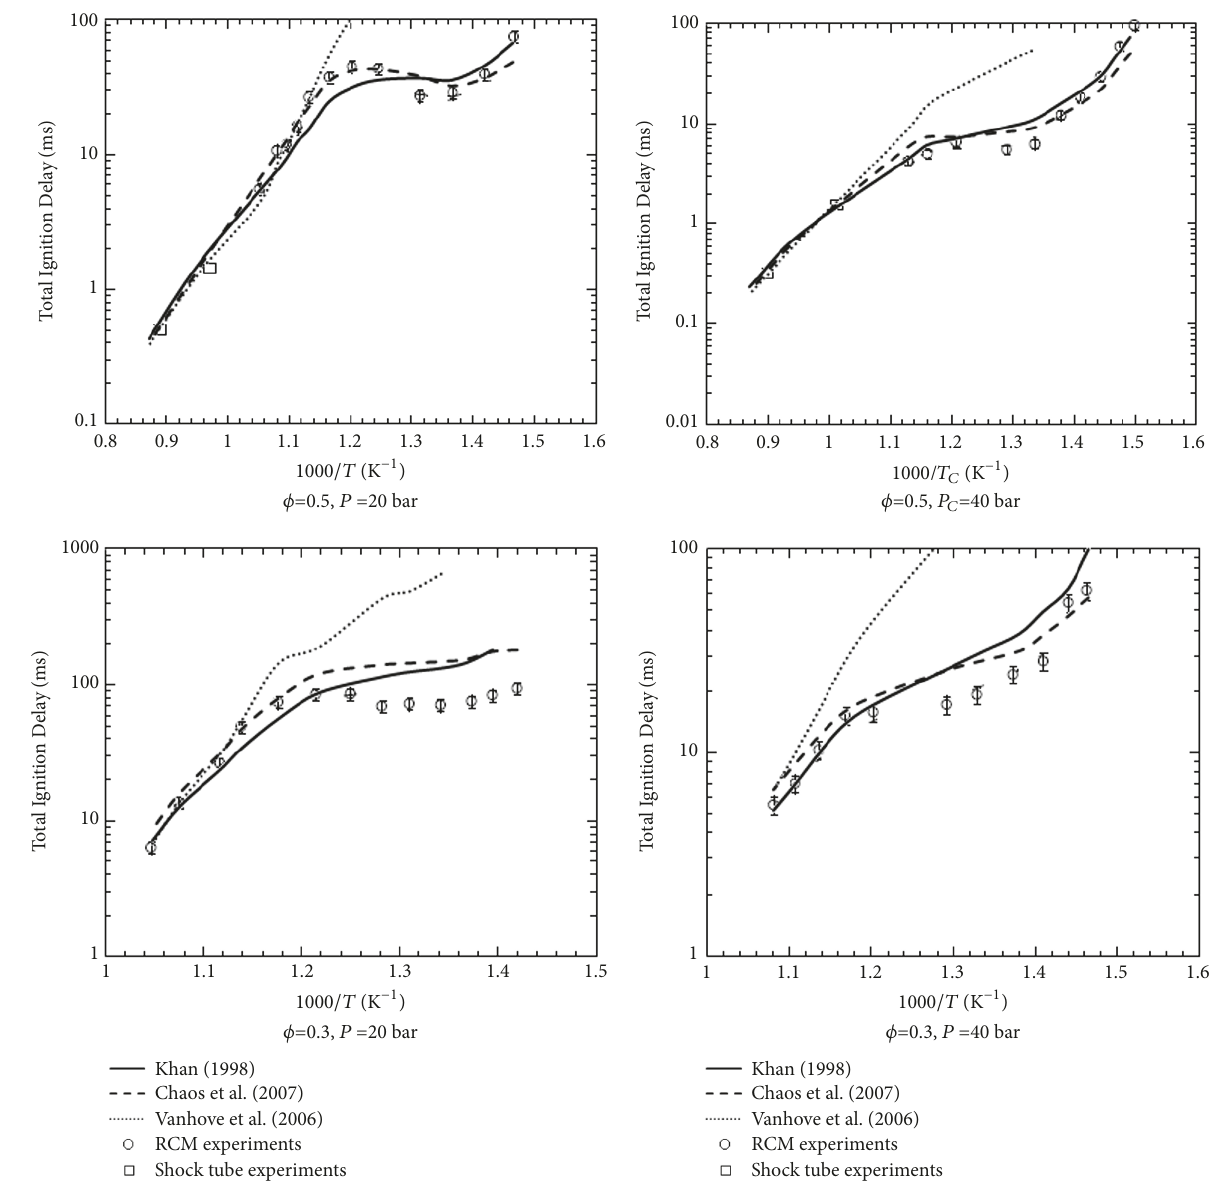
Figure 13: Comparison of RD387 experimental and simulated surrogate total ignition delay times. Experimental data is from Kukkadapu et al. [23] and Gauthier et al. [10]. Surrogate simulations were carried out using Khan [32], Chaos et al. [12], and Vanhove et al. [11] surrogates using the mechanism of Samimi Abianeh et al. [19]. Measured shock tube data are shown using ◻ at two approximate temperatures of 1000 K and 1100